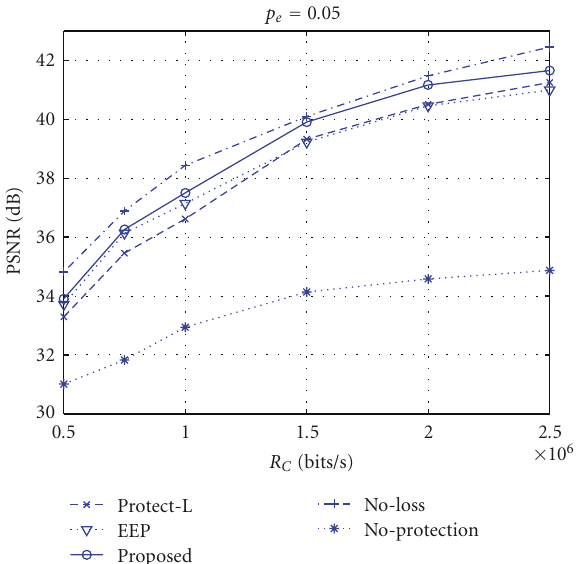
Figure 21: Results for p e = 0 . 20 for “Rena”